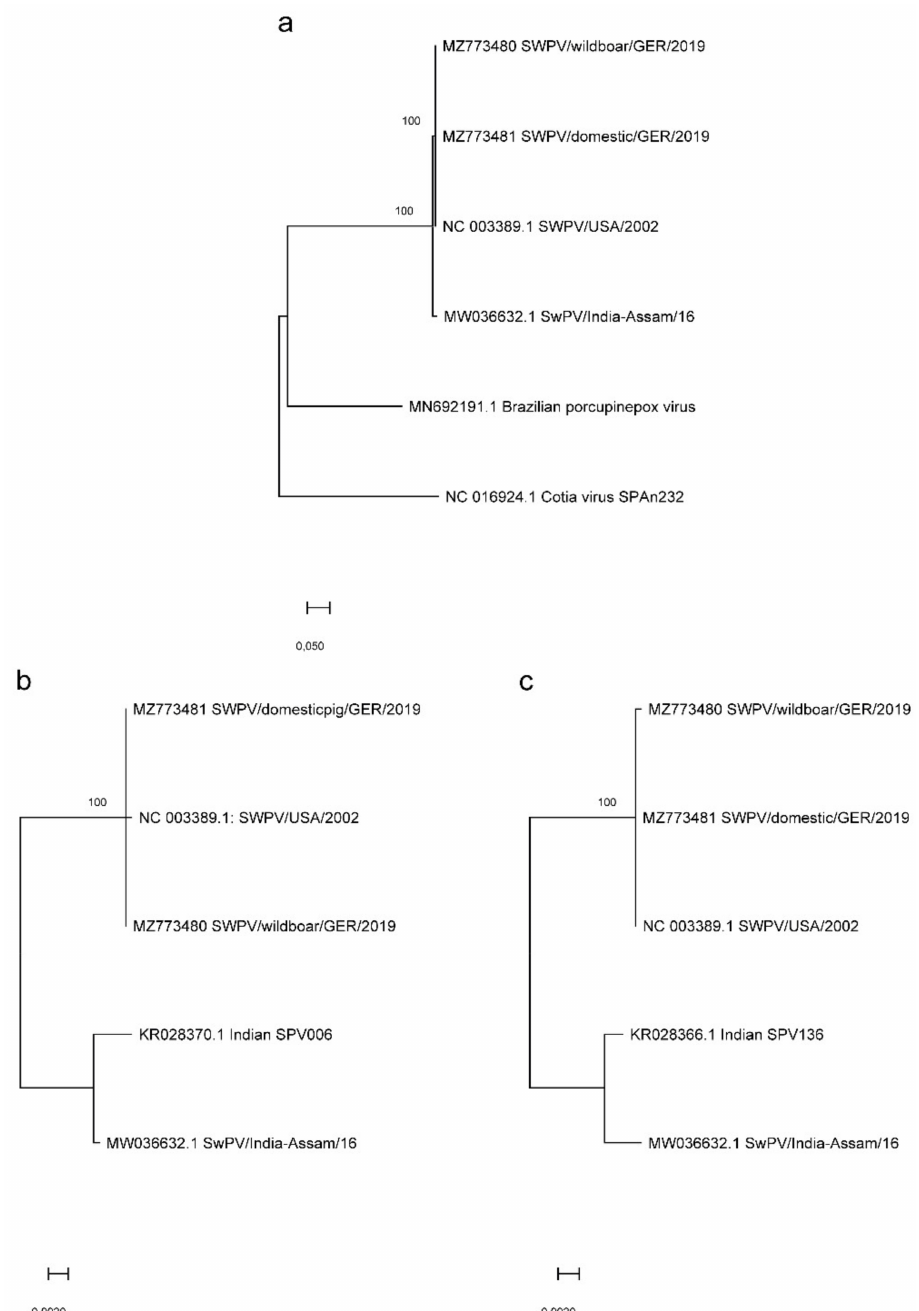
Figure 3. Phylogenetic analysis of German SWPV strains. ( a ) Maximum likelihood tree based on the full-length genome sequence of available SWPV sequences (SWPV/USA/2002, GenBank accession no. NC_003389.1 and SWPV/India-Assam/16, MW036632.1) and two full genome SWPV sequences generated in this study. Brazilian porcupinepox virus 1 strain UFU/USP001 (MN692191.1) and Cotia virus SPAn232 (NC_016924.1) were included as outgroups. ( b , c ) Maximum likelihood trees based on the nucleotide sequences of the SPV006 ( b ) and SPV136 ( c )